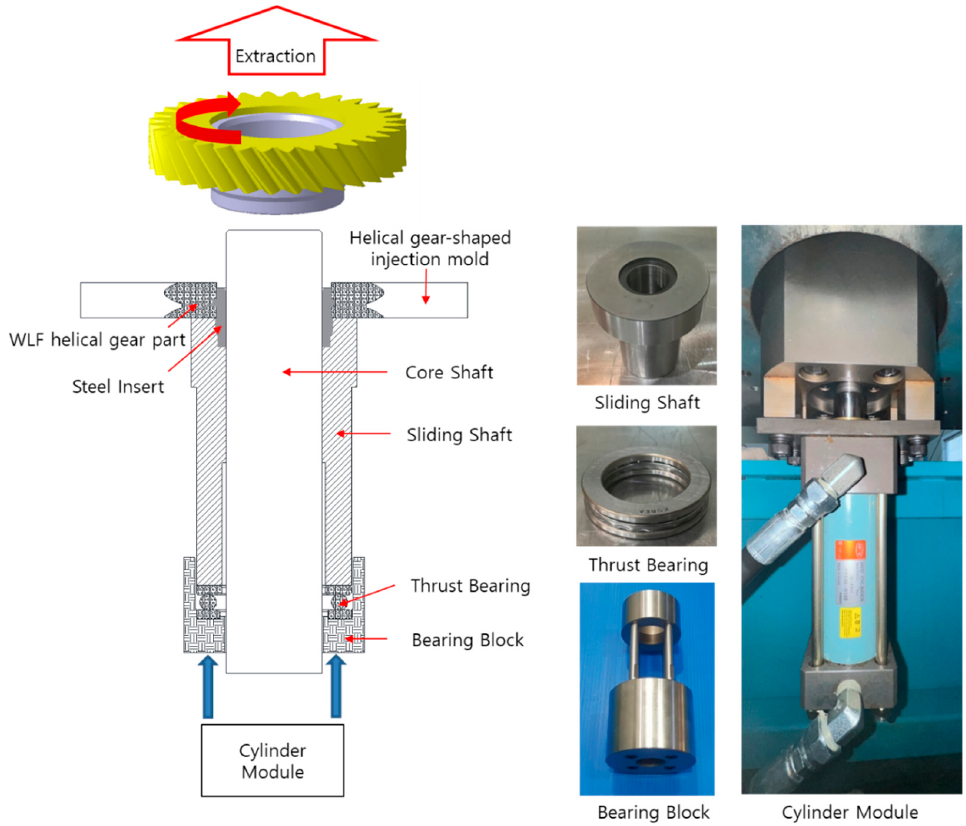
Figure 12. Principle of WLF helical gear